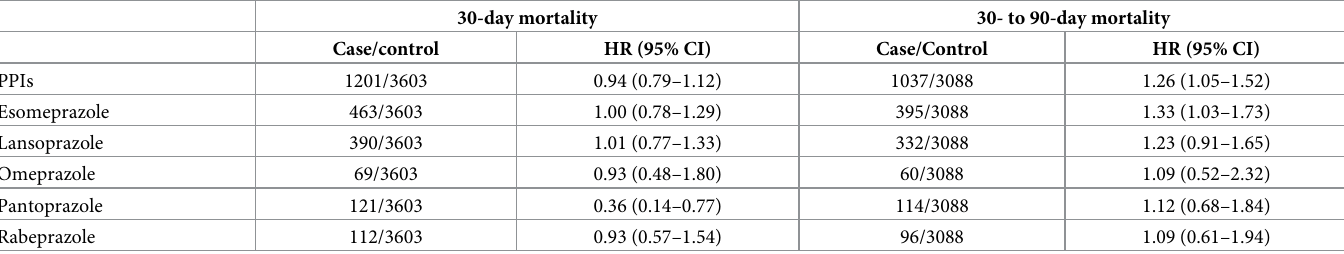
Table 3. Adjusted HRs of different PPIs for 30-day and 30 to 90-day mortality of cirrhotic patients with pneumonia and no active gastrointestinal